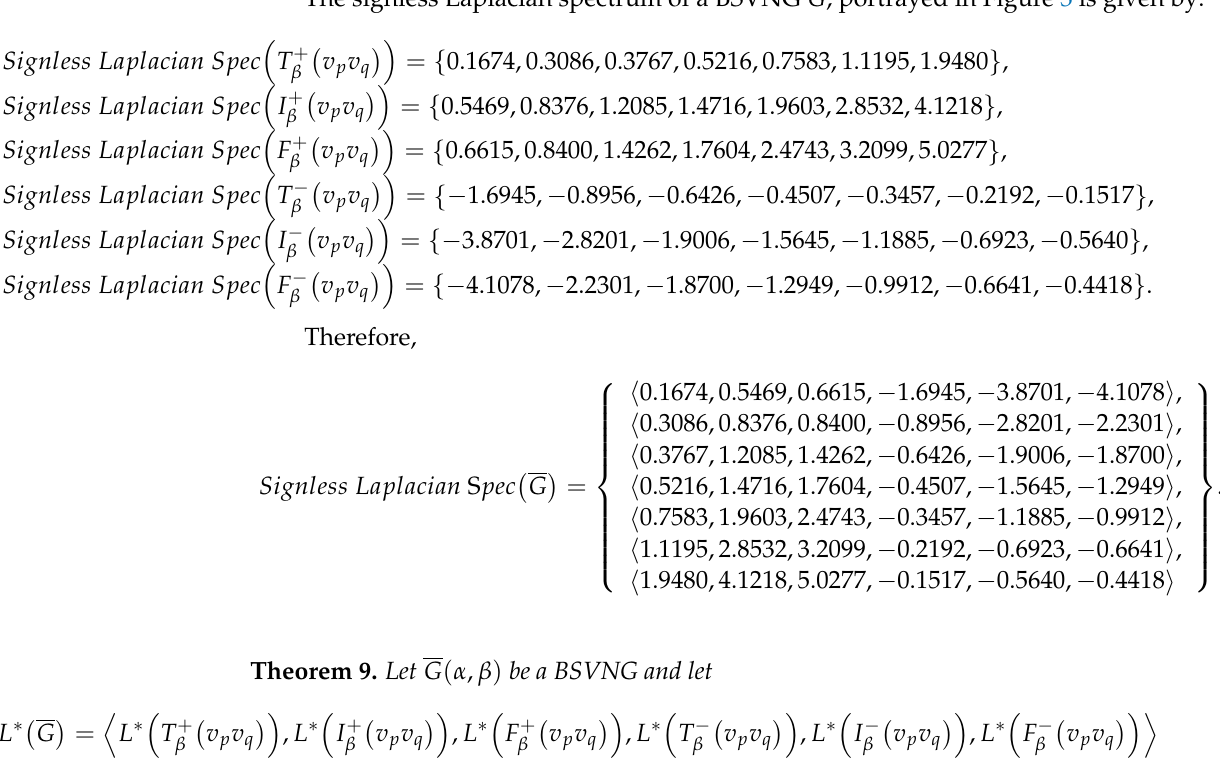
The signless Laplacian spectrum of a BSVNG G , portrayed in Figure 3 is given